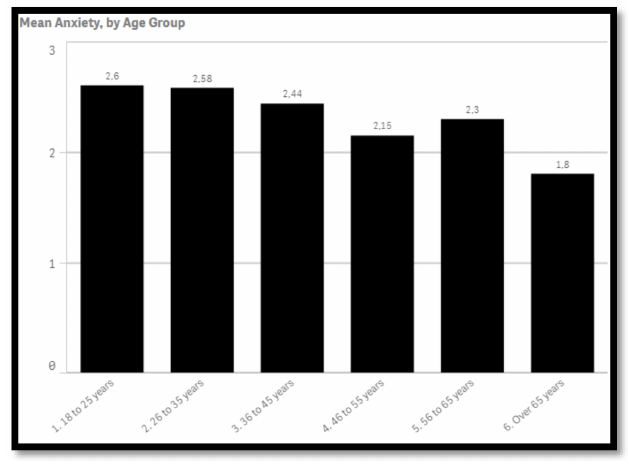
Figure 2. Anxiety, by age. Source: data study analysis.